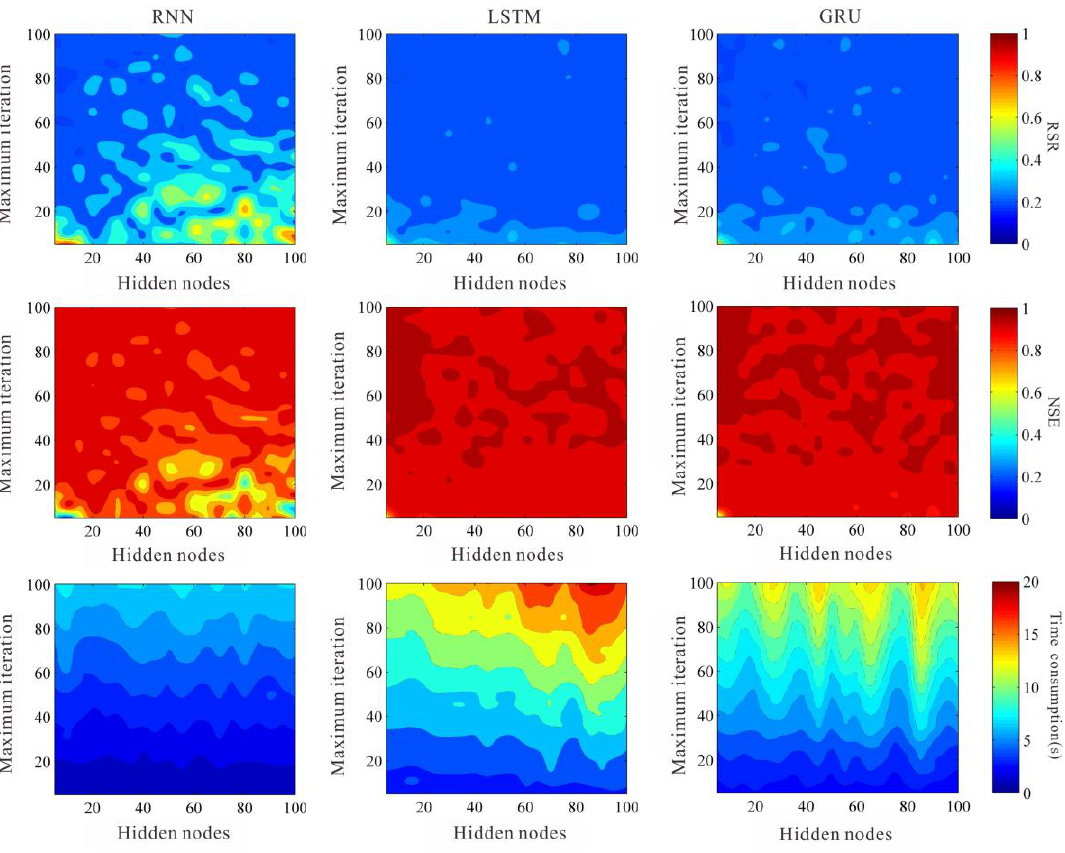
Figure 6. Performance surface diagram.